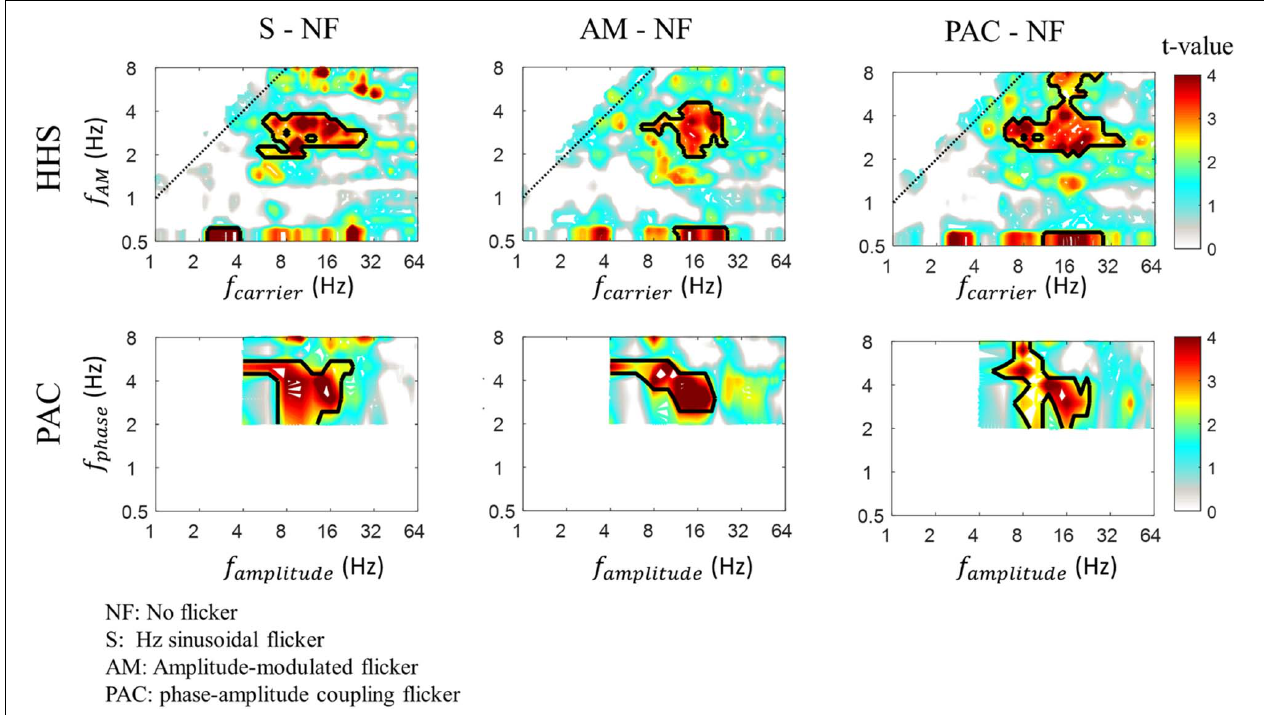
FIGURE 8 | The HHS contrast (top panels) and PAC contrast (bottom panels) of SSVEPs between testing conditions (3 Hz sinusoidal flicker, AM flicker and PAC flicker) and baseline condition (no flicker). The red area within the black contour indicates areas with significant t -values ( p < 0.05, df = 9, two-tailed, CBnPP test) of the contrast. The amplitudes of 3 Hz amplitude modulation residing in alpha/beta (8-20 Hz) rhythm are significantly